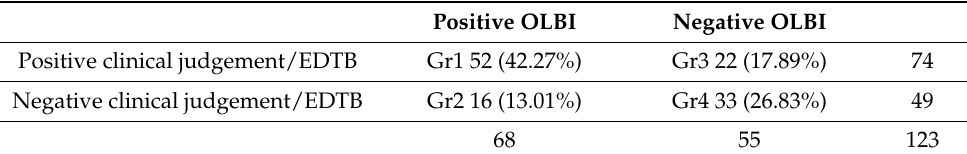
Table 5. Cross-distribution of burnout diagnoses ( N , %).